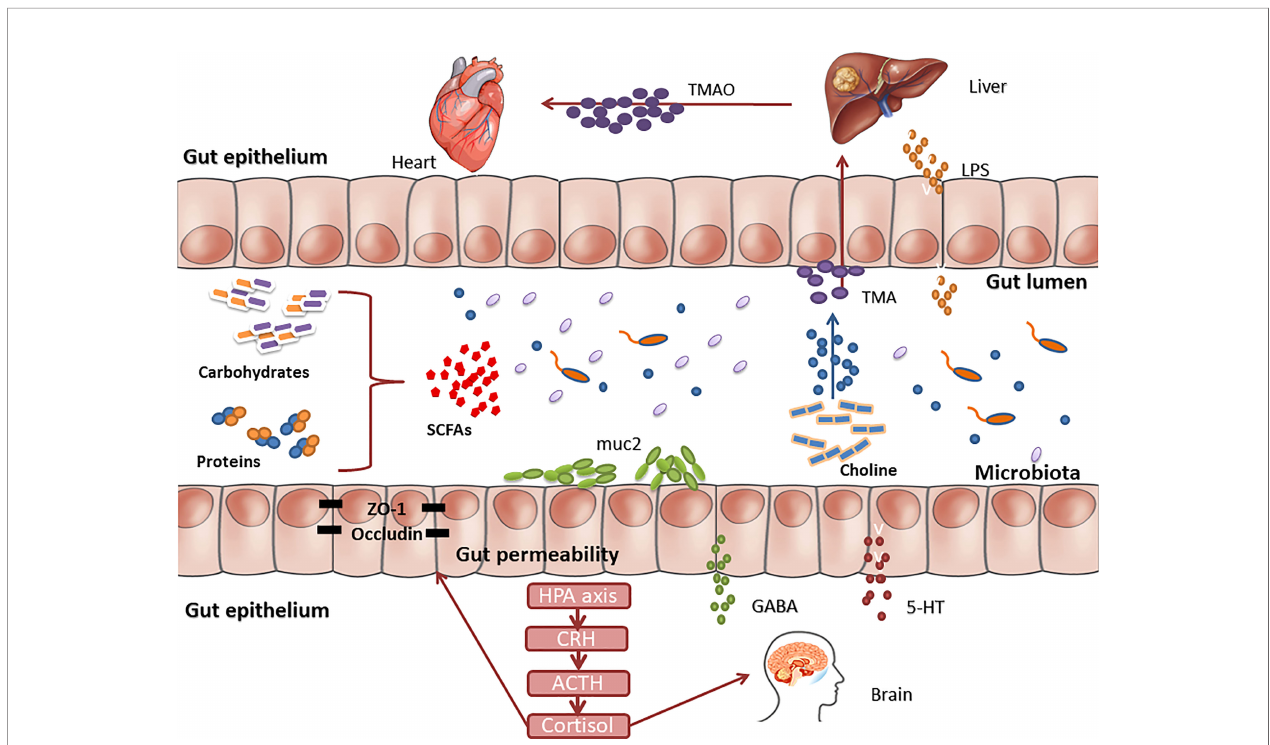
FIGURE 2 | There are multiple pathways of communication between gut microbes and human organs.TMAO is generated via a metaorganismal pathway that begins with gut microbial conversion of dietary phosphatidyl choline into trimethylamine, followed by host liver oxidation to TMAO by fl avin monooxygenases. Gut- liver axis, linking liver metabolism and gut microbiota, played an important role in the mechanisms of liver disease. Translocated LPS enters the liver through the hepatic portal vein and causes damage to liver function. Changes in the gut microbiota can affect the function of the central nervous system through multiple signaling pathways, including the hypothalamus-pituitary-adrenal axis, immune regulation, serotonin metabolism, and production of neuroactive